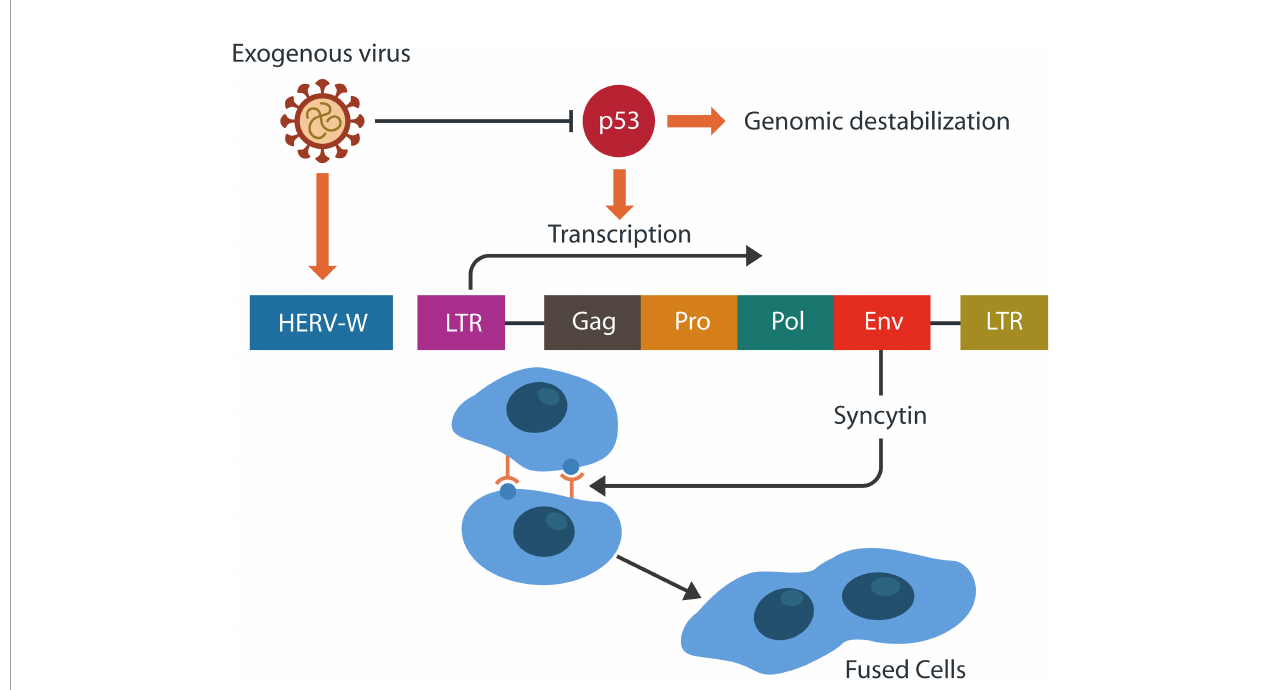
FIGURE 4 | HERVs may retain gag, pol, env genes, and one or two long terminal repeats (LTRs). Env gene encodes for syncytin-1, a physiological placental fusogen. The activity-regulated cytoskeleton-associated protein (Arc) resembles the gag gene and encodes for a retroviral capsid. Viruses often inhibit p53, the tumor suppressor, destabilizing the genome. This in return, facilitates HERV-W transcription and the formation of pathological